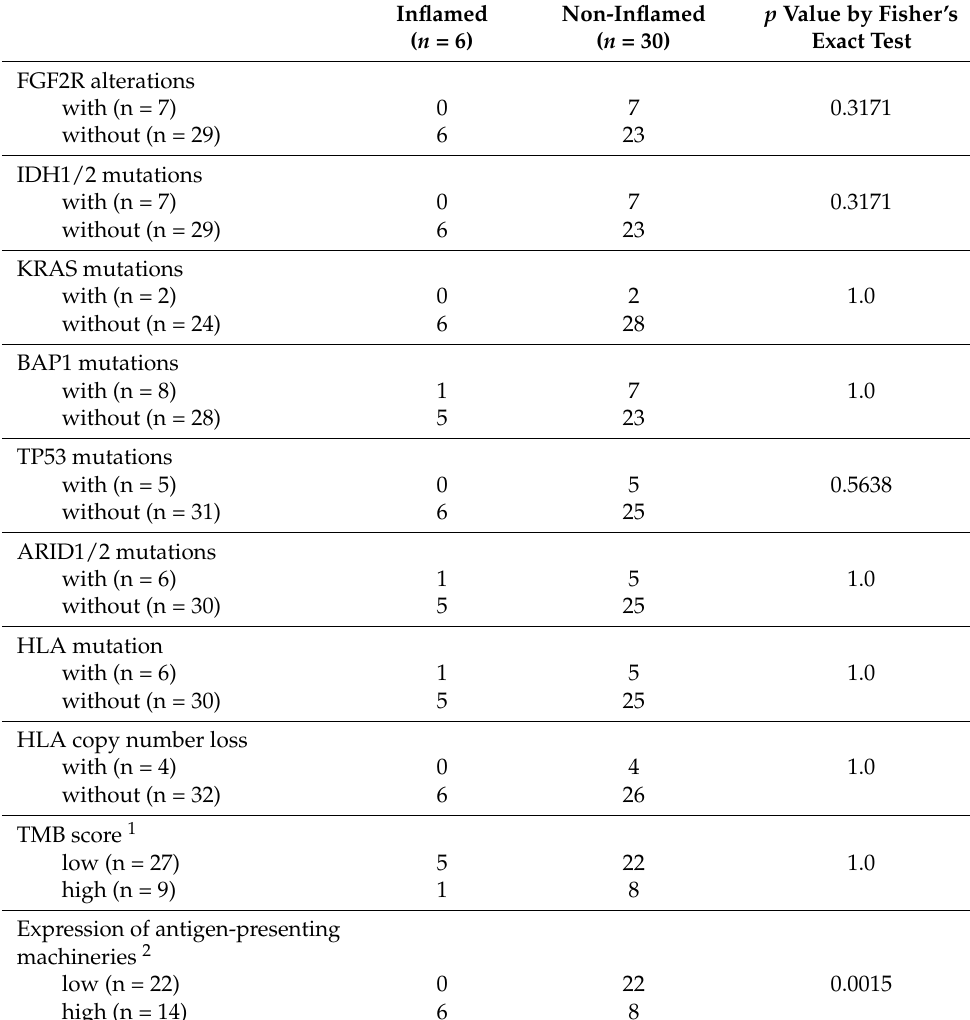
Table 1. Association between immune class and genetic and epigenetic alterations in cholangiocarci- noma.